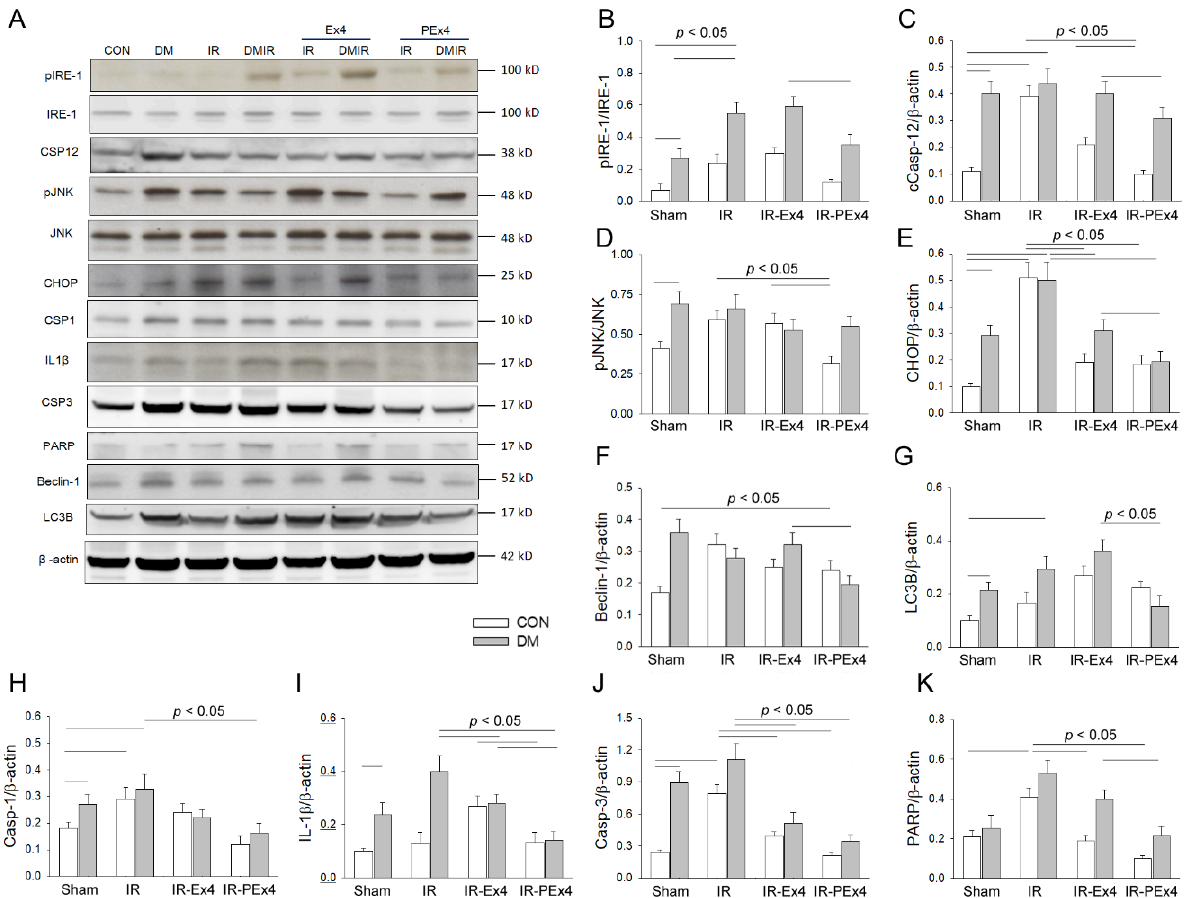
Figure 5. The effect of Ex-4 and PEx-4 treatment on IR-evoked ER stress-, autophagy-, pyroptosis- and apoptosis-associated proteins in Con or DM rat brain ( A ). The levels of ER stress-associated proteins including pIRE-1 ( B ), cleaved Caspase-12 ( C ), pJNK ( D ), CHOP ( E ), autophagy-associated proteins including Beclin-1 ( F ), LC3B ( G ), pyroptosis-associated protein Caspase-1 ( H ), IL-1 β ( I ) and apoptosis-associated proteins including cleaved Caspase-3 ( J ) and PARP ( K ) are compared in DM as compared to Con. IR in Con and DM groups further and significantly enhanced pIRE-1, Caspase 12, pJNK, CHOP, Caspase-1, IL-1 β , Beclin-1, LC3B and cleaved Caspase-3 and PARP expression as compared to respective Con and DM groups. Ex-4 and PEx-4 treatment with IR injury significantly down-regulated ER stress, pyroptosis, autophagy and apoptosis in the Ex-4-treated IR group (IR-Ex4) and PEx-4-treated IR group (IR-PEx4) of Control and DM rats. Data are expressed as mean ± SEM in each group ( n = 6) using the single values. The statistical difference is indicated by the horizontal line with p < 0.05 between groups using one-way ANOVA, followed by Bonferroni’s post hoc test. Each symbol represents one sample in different